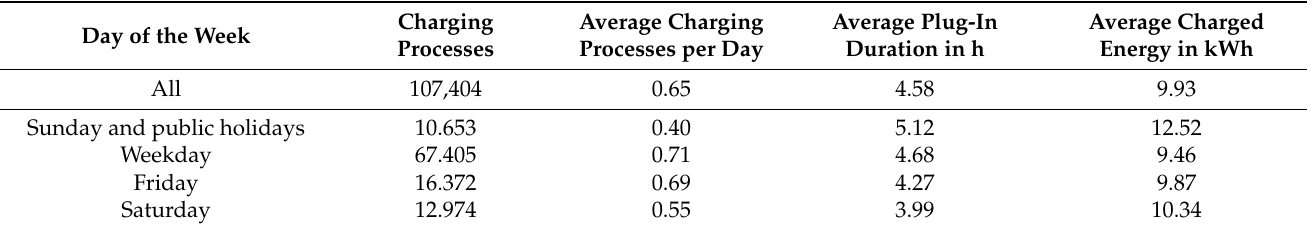
Table A1. Characteristics of the processed data classified by type-days including the calculation of public holidays as Sundays.